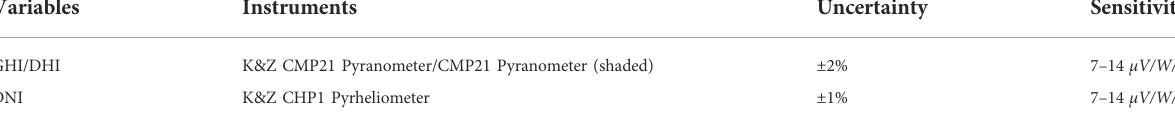
TABLE 2 Instrument speci fi cations.